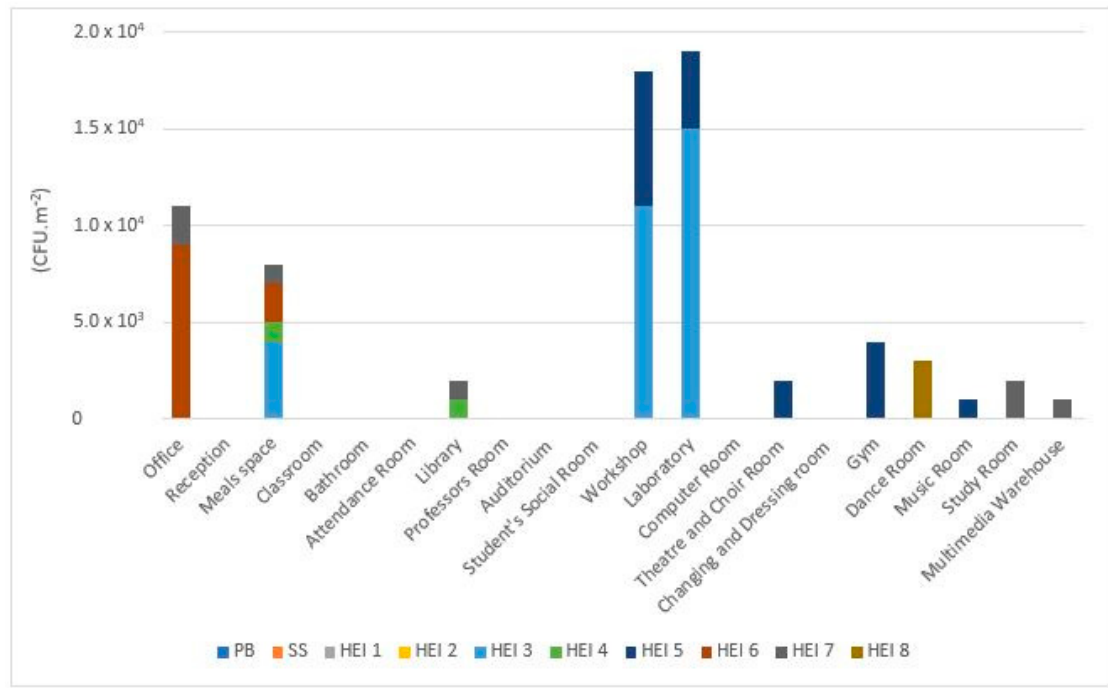
Figure 3. Gram-negative bacteria in surface swabs.